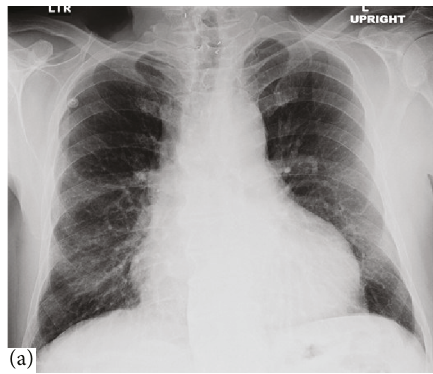
Figure 2: CXR of the lungs (posteroanterior view) on admission shows a mildly enlarged cardiomediastinal silhouette that resembles a